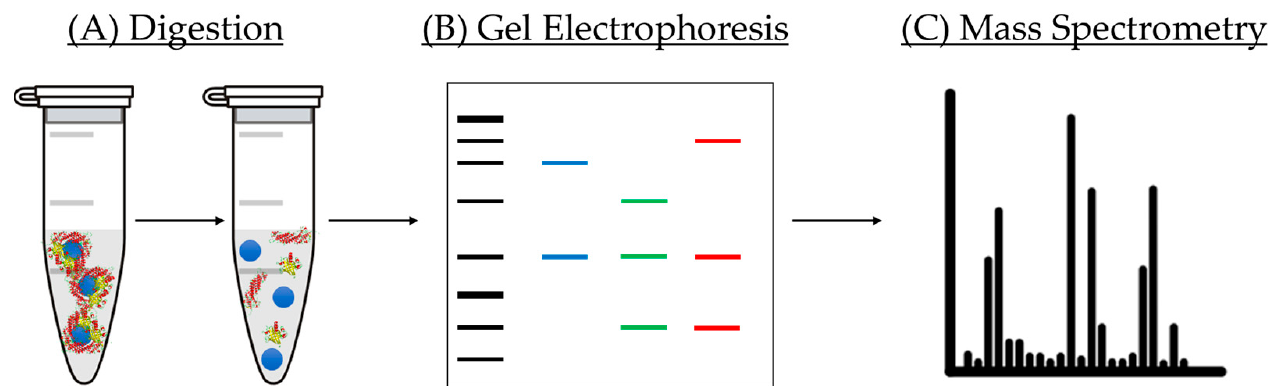
Figure 10. Scheme of the steps followed for analysis of the coronas of NMs: ( A ) digestion allows separation from proteins from the NM surface; ( B ) gel electrophoresis is used for separating proteins of different molecular weight; ( C ) ionized samples are separated by liquid chromatography and analyzed by mass spectrometry.